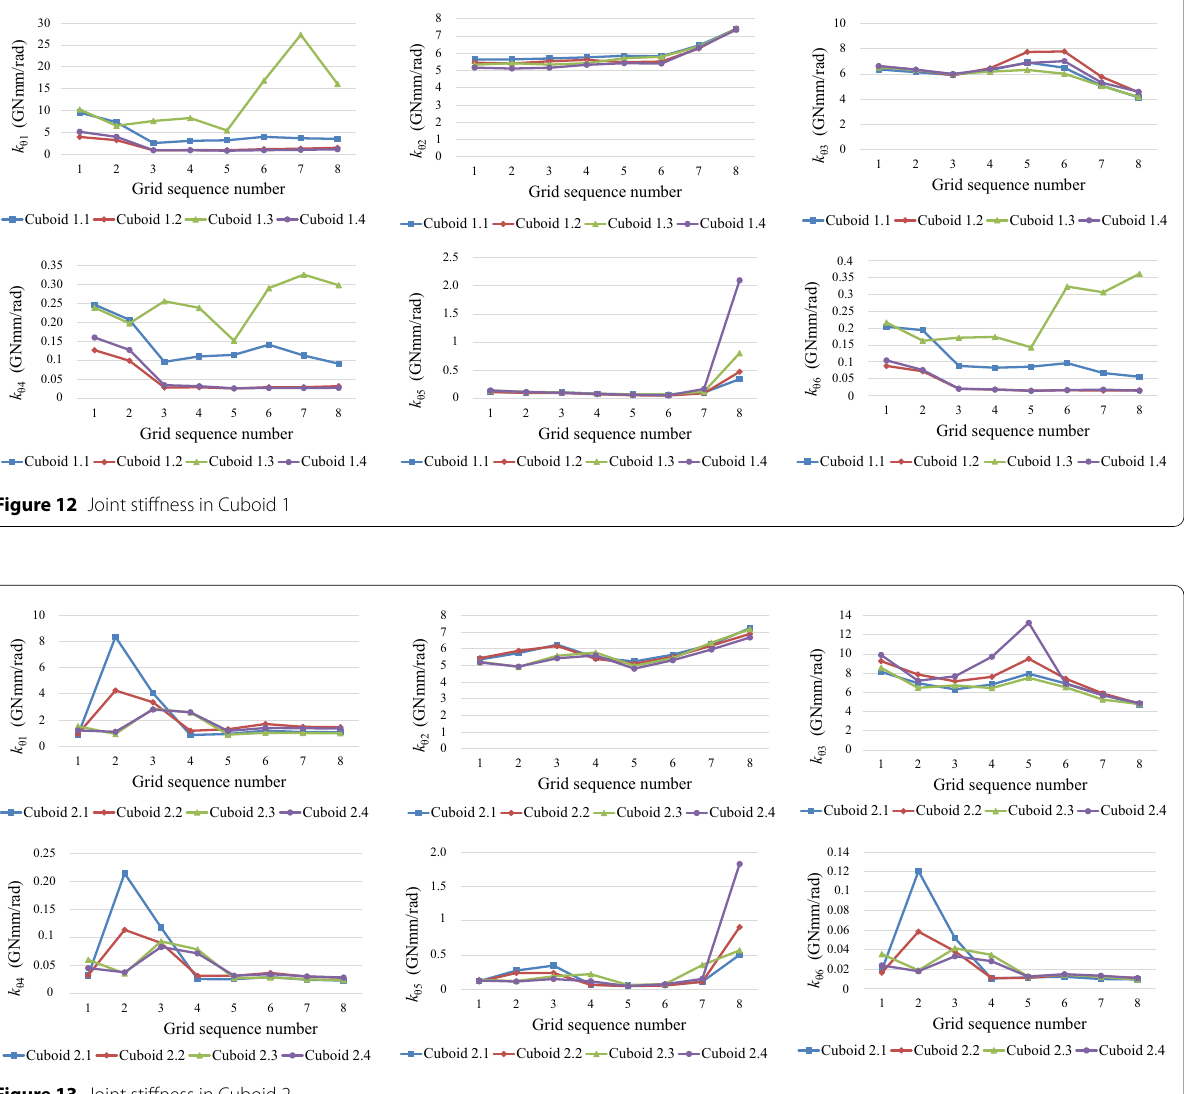
Figure 13 Joint stiffness in Cuboid